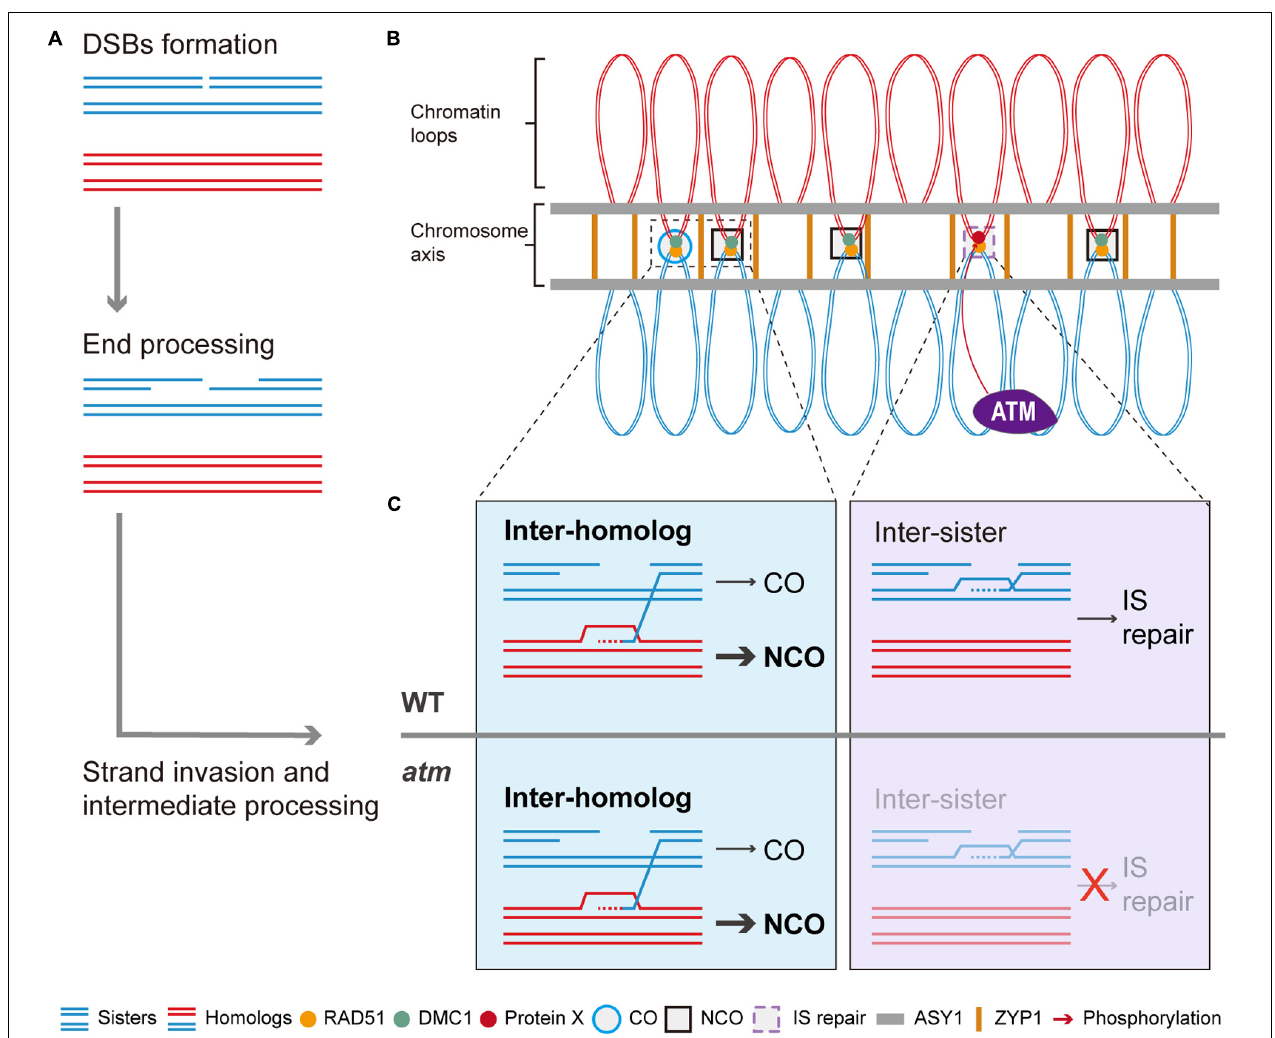
FIGURE 8 | Model of ATM promote RAD51 mediated inter-sister meiotic DSB repair. After meiotic DSBs are formed, it will be processed to generated the 3’ ssDNAs (A) . With the help of RAD51 and DMC1, some of the ssDNAs will invade homologous chromosomes to seek template for repair (A,B) . Those DSBs repaired using homologous chromosomes will generate COs or NCOs while NCOs are in the majority (B,C) . Whereas some of the DSBs are repaired through inter-sister recombination which is mediated by RAD51 (B,C) . Thus, we proposed that ATM could promote this RAD51-mediated inter-sister repair process and it is